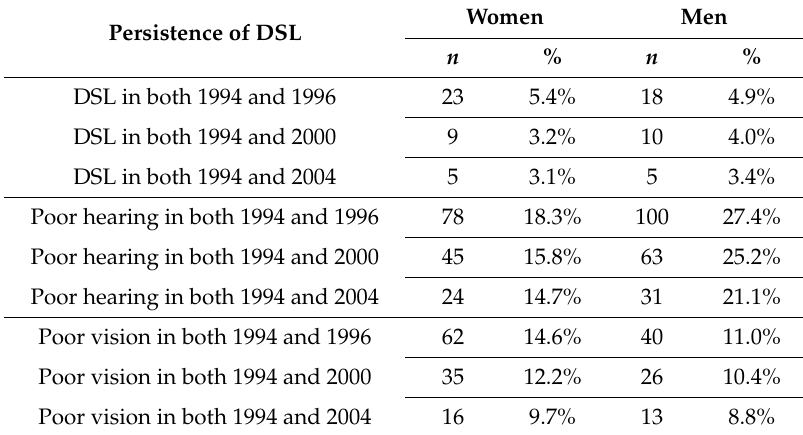
Table 4. Persistent DSL, vision loss and hearing loss in 2 years, 6 years and 10 years post baseline. Persistence of